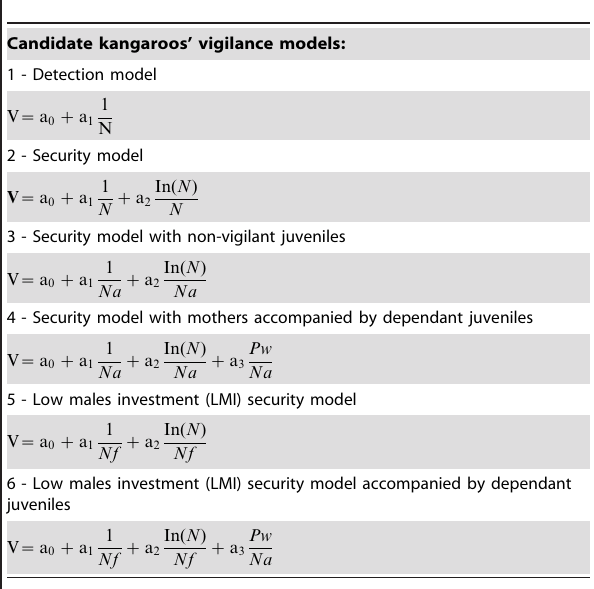
Table 1. Candidate vigilance models modified from Dehn